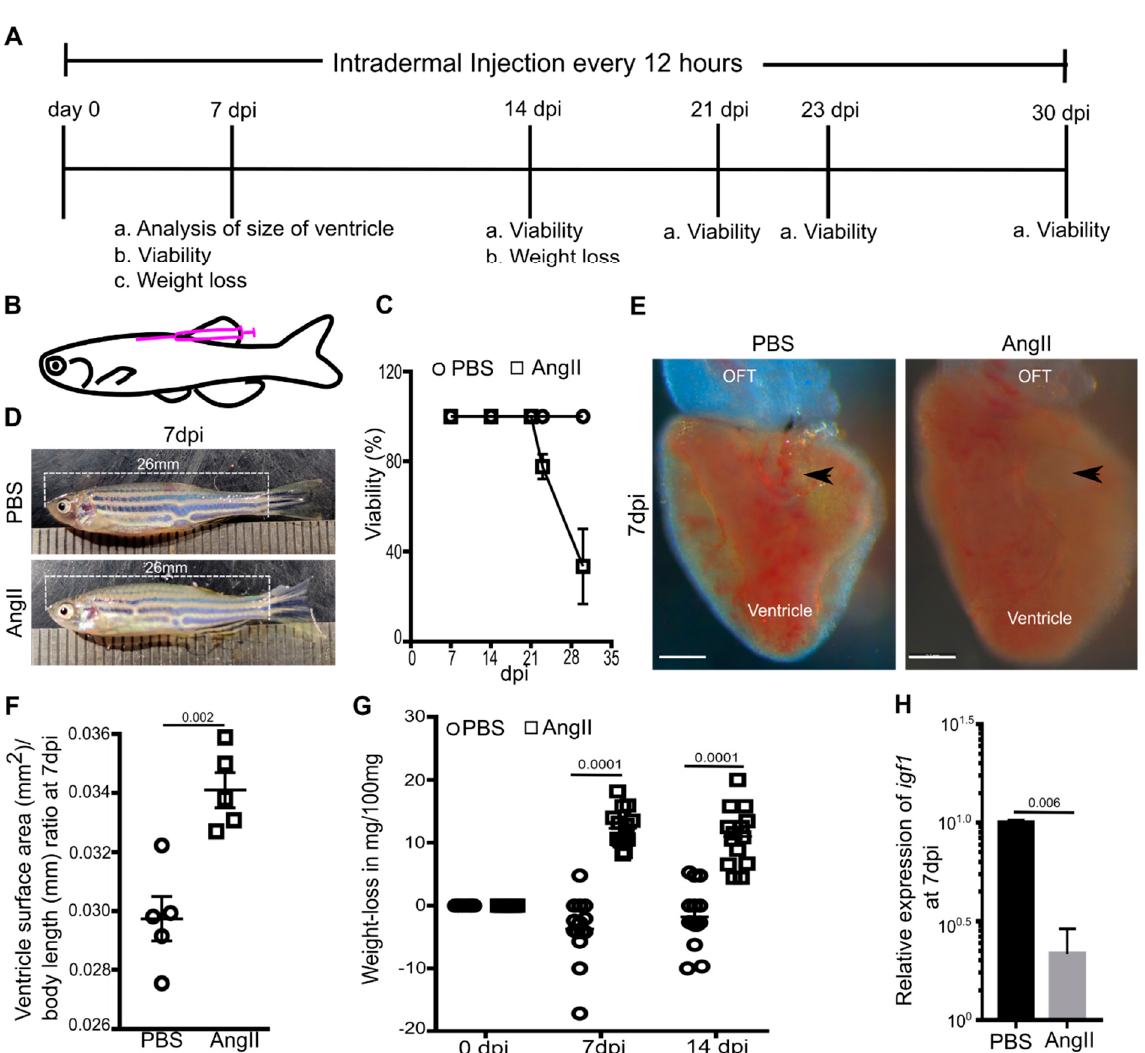
Figure 1. Intradermal Angiotensin II injection induces cardiac hypertrophy in adult zebrafish. ( A , B ) Diagrams showing experimental procedure ( A ) and site of intradermal injection ( B ). ( C ) Survival assay assessed the viability of the PBS or AngII injected animals at different time points ( n = 18 each from 3 independent experiments). Error bars indicate the mean ± s.d. ( D ) Images of PBS or AngII injected zebrafish at 7 dpi. ( E ) Bright-field images of cardiac ventricles isolated from PBS or AngII injected animals at 7 dpi. Arrowheads indicate the atrioventricular canal. Scale bars, 200 µm. ( F ) Statistical analysis of the ratio of the 2D surface area of the ventricle and body length of individual fish at 7 dpi ( n = 5 each from 2 independent experiments). ( G ) Quantitative analysis of weight loss in 14 PBS injected and 14 AngII injected zebrafish from 3 independent experiments. ( H ) Quantitative analysis of the expression of igf1 in cardiac ventricles from PBS or AngII injected animals at 7 dpi ( n = 3, each sample represents a pool of 6 hearts). Error bars indicate the mean ± s.e.m. dpi: days post-injection; OFT, outflow tract. Significant, p < 0.05; non-significant, p ≥ 0.05.